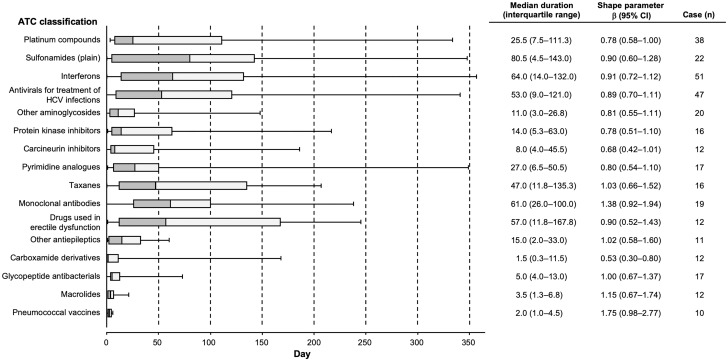
A box plot and the Weibull shape parameter of drug-induced hearing loss for each ATC classification of drugs.